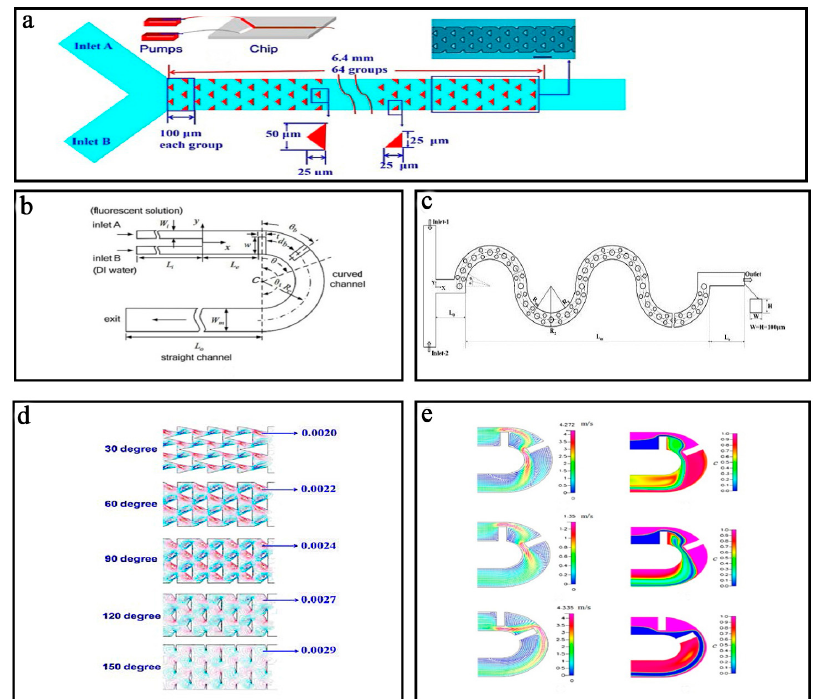
Figure 11. Schematic of the obstacle based micromixer ( a ) with triangle barriers, ( b ) with radial barriers, and ( c ) with cylindrical barriers; ( d ) The simulation results of the obstacle based micromixer with triangle barriers; ( e ) The simulation results of the obstacle based micromixer with radial barriers. Reproduced with permission from